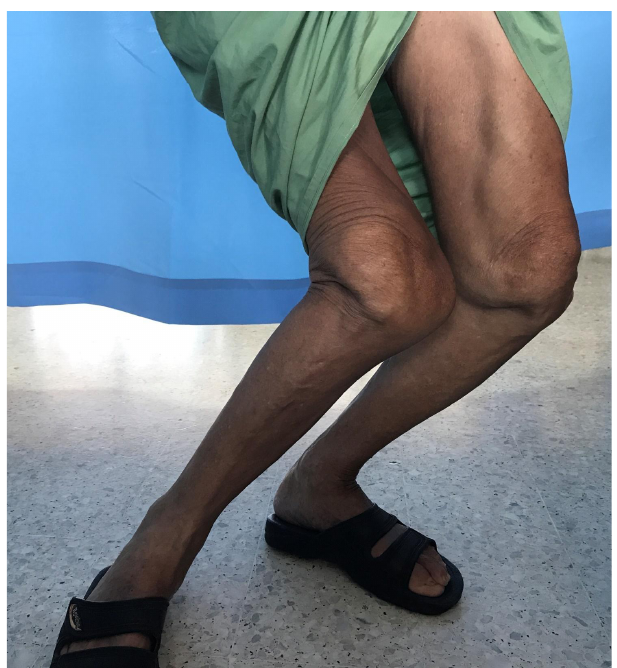
Figure 1 . Knee Examination Bilaterally while Bearing Weight. Windswept Deformity towards the left of the patient.